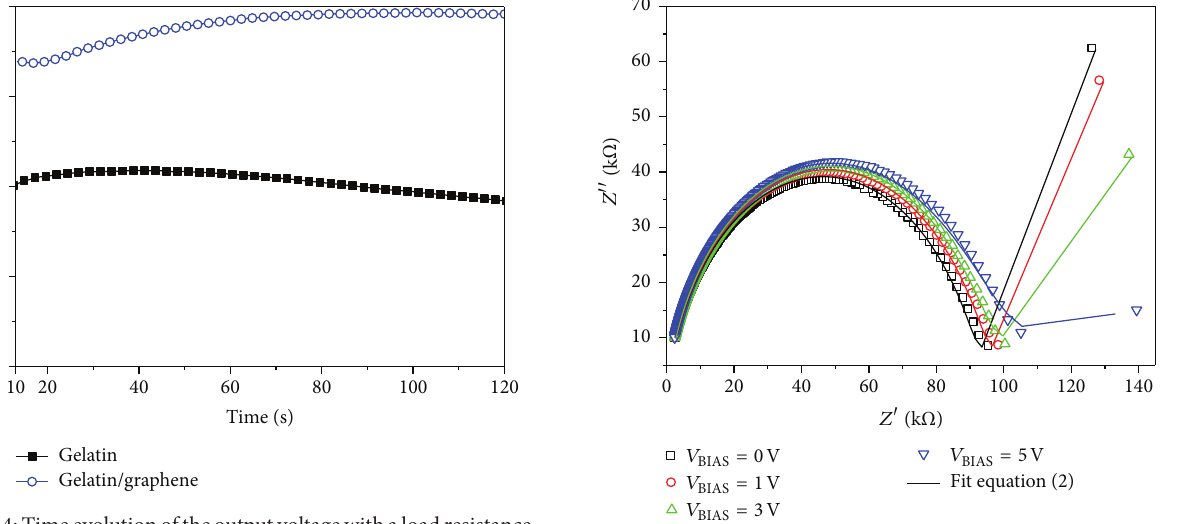
Figure 6: Plot of the imaginary part versus real part of the device impedance for pure gelatin based device, measured for four different bias voltages in a frequency range between 100Hz and 100KHz at room temperature. Solid lines are the best fit of the measured impedance with (2).